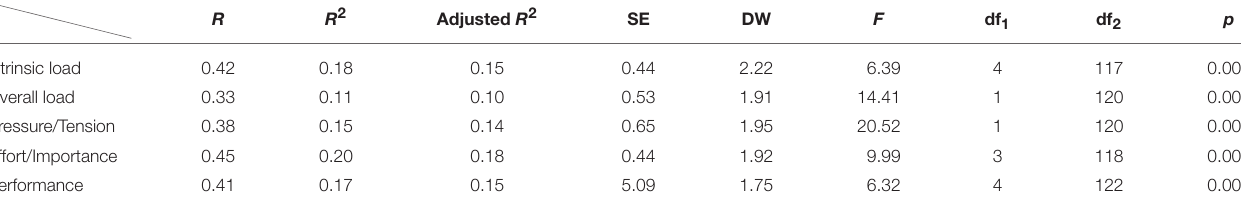
TABLE 3 | Summary of models.